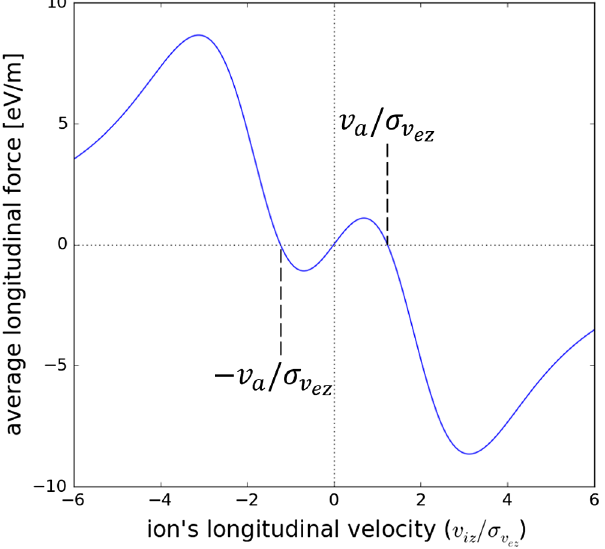
FIG. 3. Effective average friction force acting on the ions.